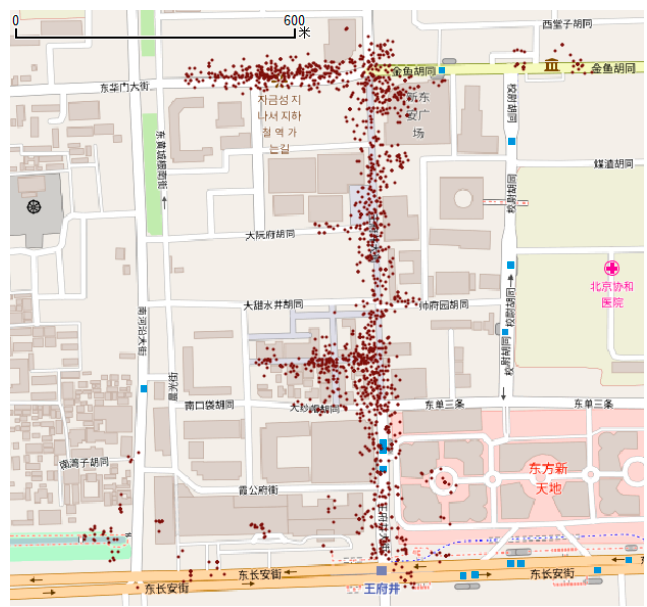
Figure 9. Final clustering outputs after class mergence.